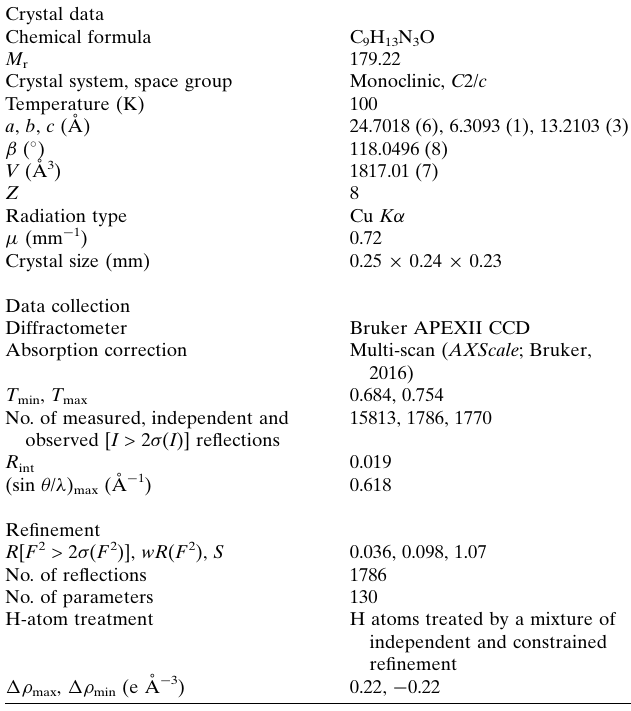
Figure 4 Energy frameworks for separate ( a ) electrostatic and ( b ) dispersion contributions to the ( c ) total pairwise interaction energies in ( I ). The cylinders link molecular centroids, and the cylinder thickness is proportional to the magnitude of the energies (see Fig. 3). For clarity, the cylinders corresponding to energies <5 kJ mol (cid:3) 1 are not shown. The directionality of the crystallographic axes is the same for all three